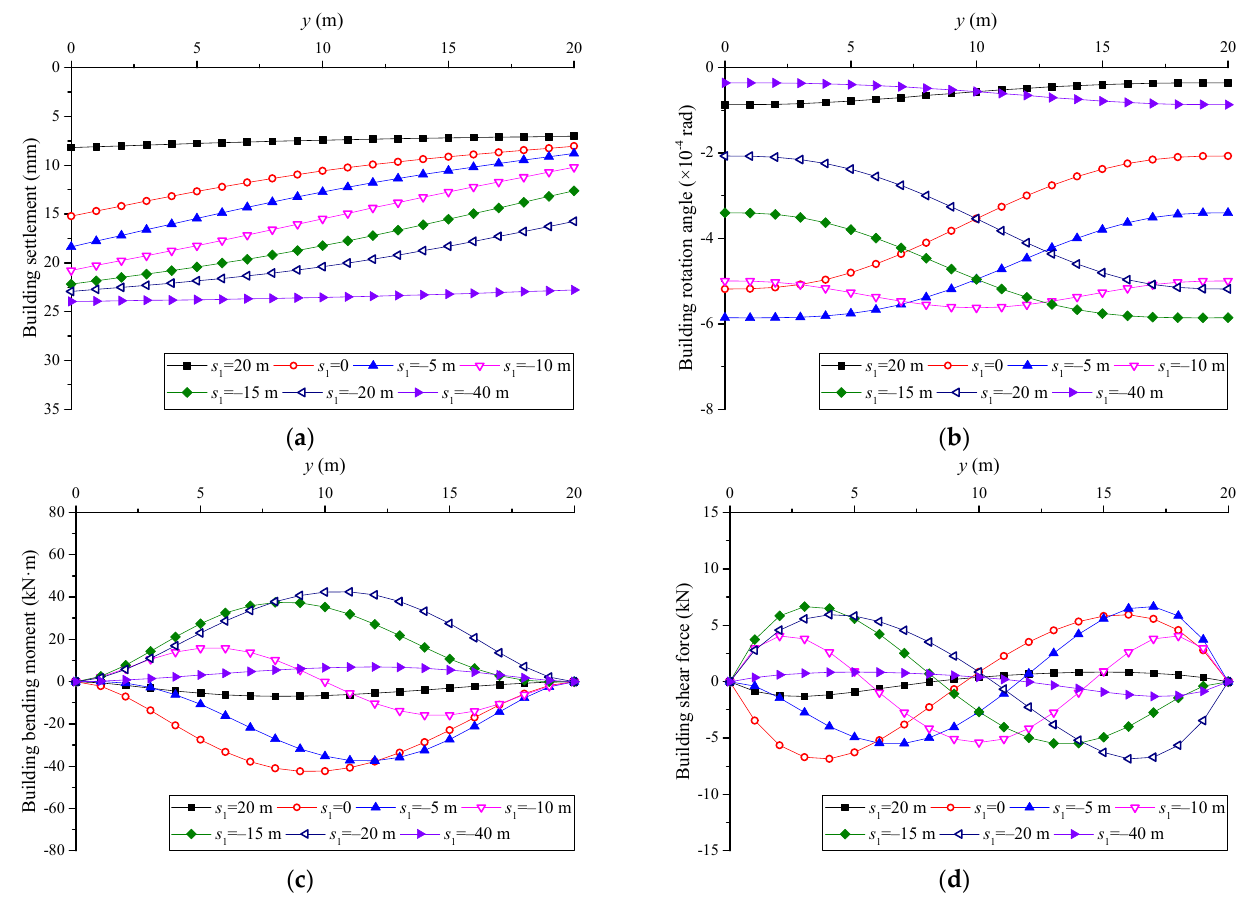
Figure 10. Building response with different distances from tunnel face: ( a ) settlement; ( b ) rotation angle; ( c ) bending moment; ( d ) shear force.